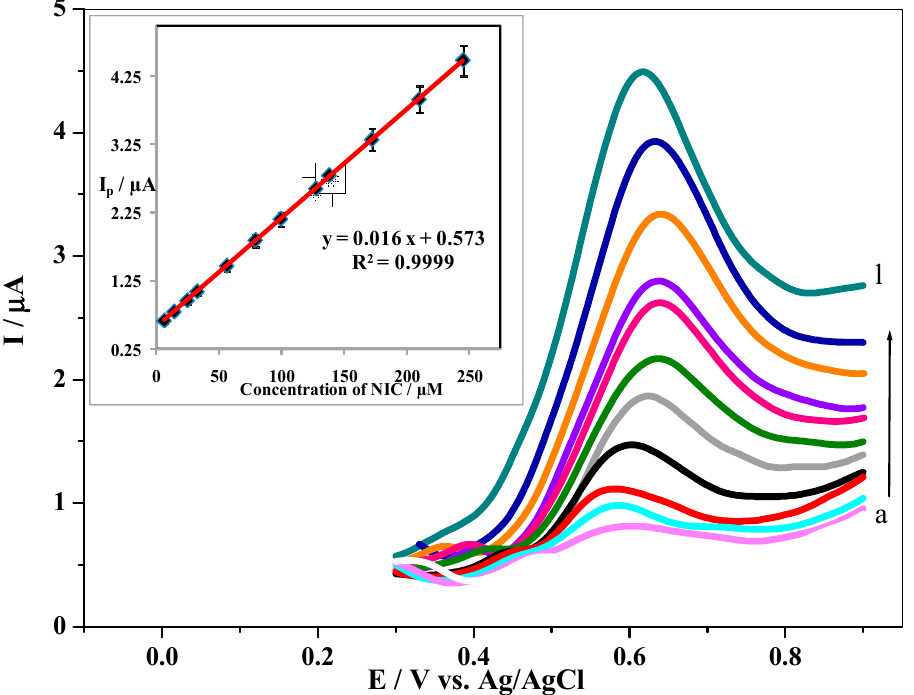
Figure 11. DPVs of 0.1 M of Na 2 SO 4 (pH 8.0) containing different concentrations of NIC: (a to l: 6.5, 15, 25, 33.5, 56.5, 80, 100, 128, 138.5, 172.5, 210, and 245 µ M) at the GO/Nq/GCE. Inset shows the corresponding calibration curve.